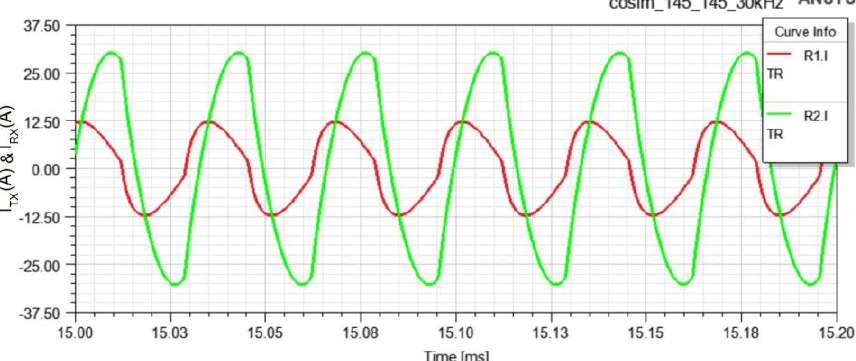
Figure 12. Current waveforms of transmitter (green) and receiver (red) coils.